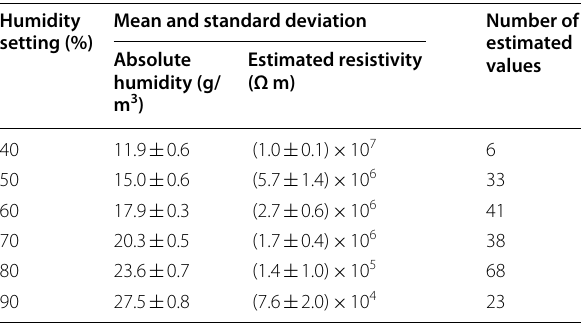
3 (standard deviation) were removed ± ×